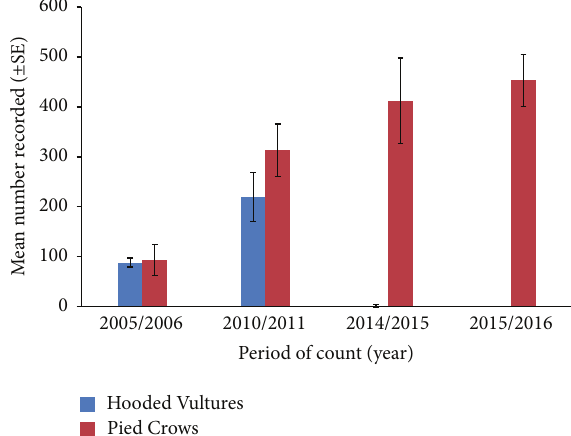
Figure 1: Number of Hooded Vultures and Pied Crows counted in important foraging areas of vultures on the Legon